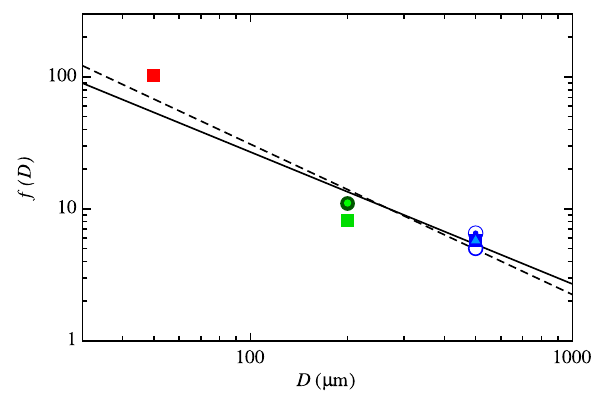
FIG. 10. (a) Asymptotic jet velocity V ( (cid:7) ) as a function of the j horizontal focus displacement of the laser for the 200 - (cid:1) m tube. The black curve shows the normalized vaporized-liquid volume determined by geometrical-optics approximation in both graphs as a function of the (right y axis). (b) Asymptotic jet velocity V j vertical focus displacement of the laser. The inserts show the capillary and the laser focus (triangle) and the directions of l h and l as seen from the capillary v